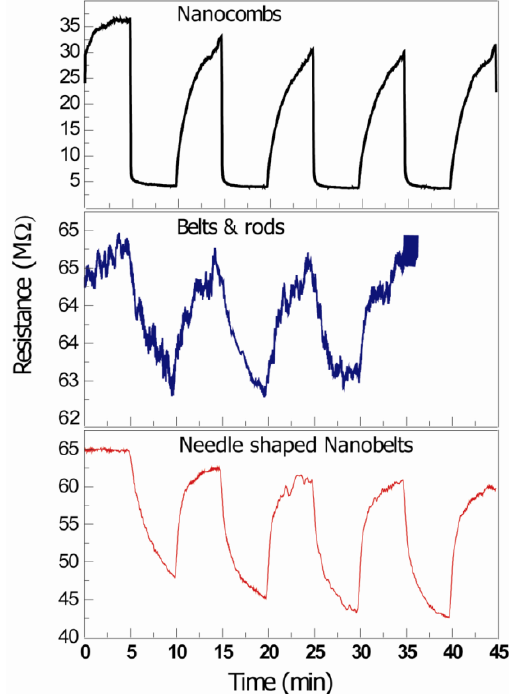
Figure 5. UV sensing at room temperature with ( a ) Comb-like structures; ( b ) Nanobelts with needles and ( c ) Mixture of rod and belts. 18 W UV lamp was used for this purpose.